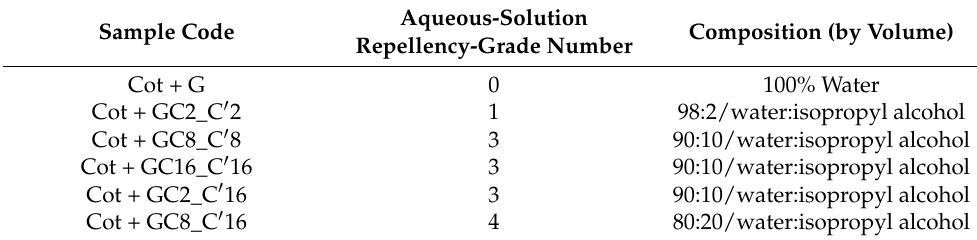
Table 3. Aqueous-liquid repellency test.